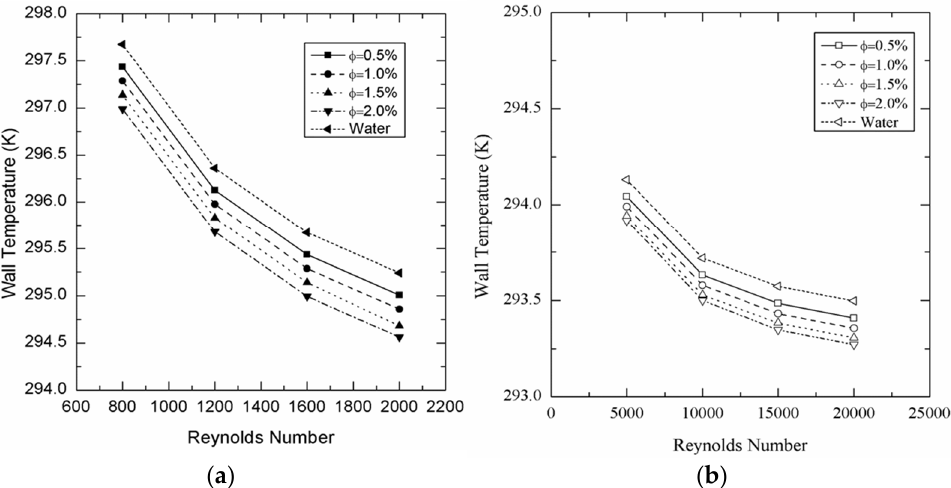
Figure 4. Variation of wall temperature with Re for TiO 2 -water nanofluid. ( a ) Laminar condition. ( b ) Turbulent condition.